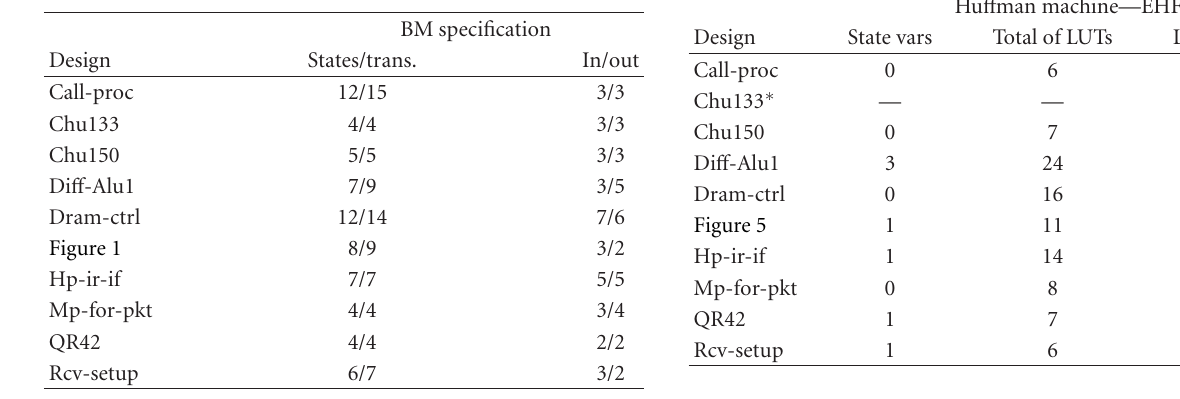
Figure 13: Simulation of the mp-for-pkt: with transient essential hazard. Table 1: BM specifications show data.